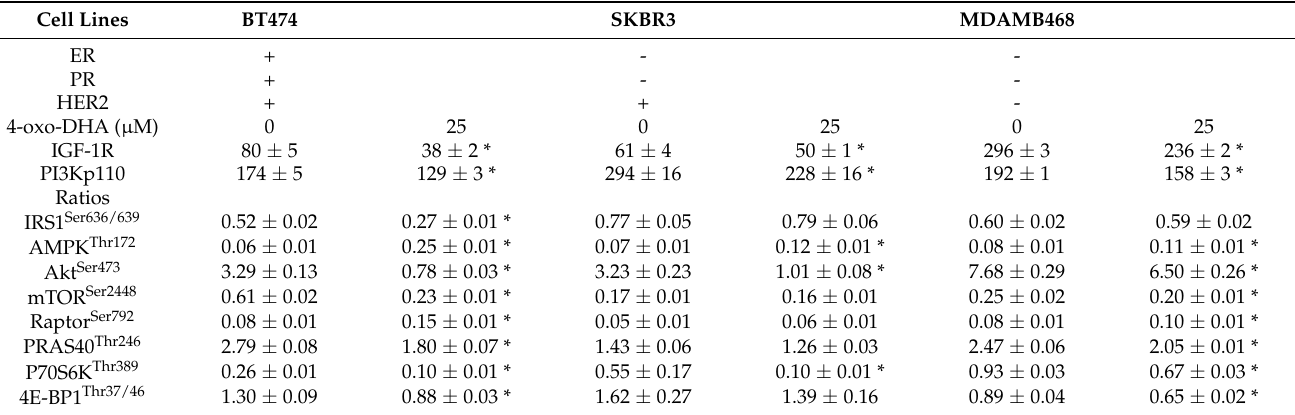
Figure 4. Effect of 4-oxo-DHA on Cell Transcription Factors. Levels of cell proliferation or apoptosis and associated target proteins in three human breast cancer cell lines (BT474, SKBR3, and MDAMB468); ( a ) orthogonal projections to latent structures-discriminant analysis (OPLS-DA) shows a 3-class supervised model and partition the sources of variation; ( b ) to visualize the misclassification rate, the dendrogram depicts hierarchical clustering patterns among three different cell lines. Table 3. Effect of 4-oxo-DHA on Growth Factor Signaling.